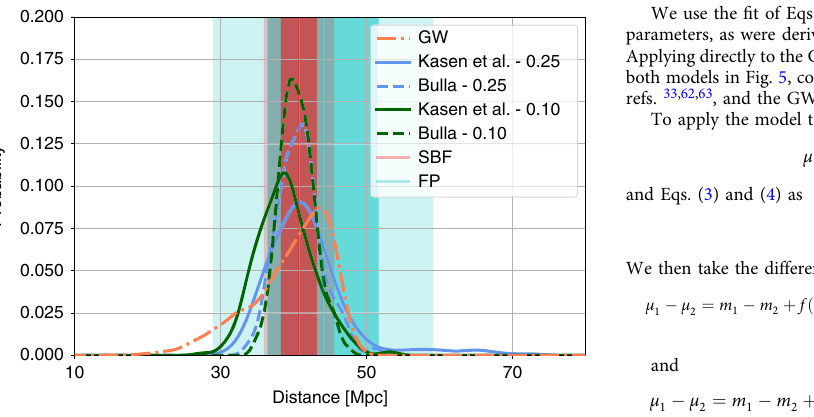
Fig. 5 Posterior distributions for distance to GW170817. We show the results of the GW-only analyses (high spin) 36 , the Kasen et al. 24 and the Bulla 25 kilonova analysis for both systematic errors assumed. The 1- and 2- σ regions determined by the surface brightness fl uctuations (SBF) of NGC 4993 (blue) 33 and the Fundamental Plane (FP) of E and S0 galaxies (red) 62 are also depicted as vertical bands.